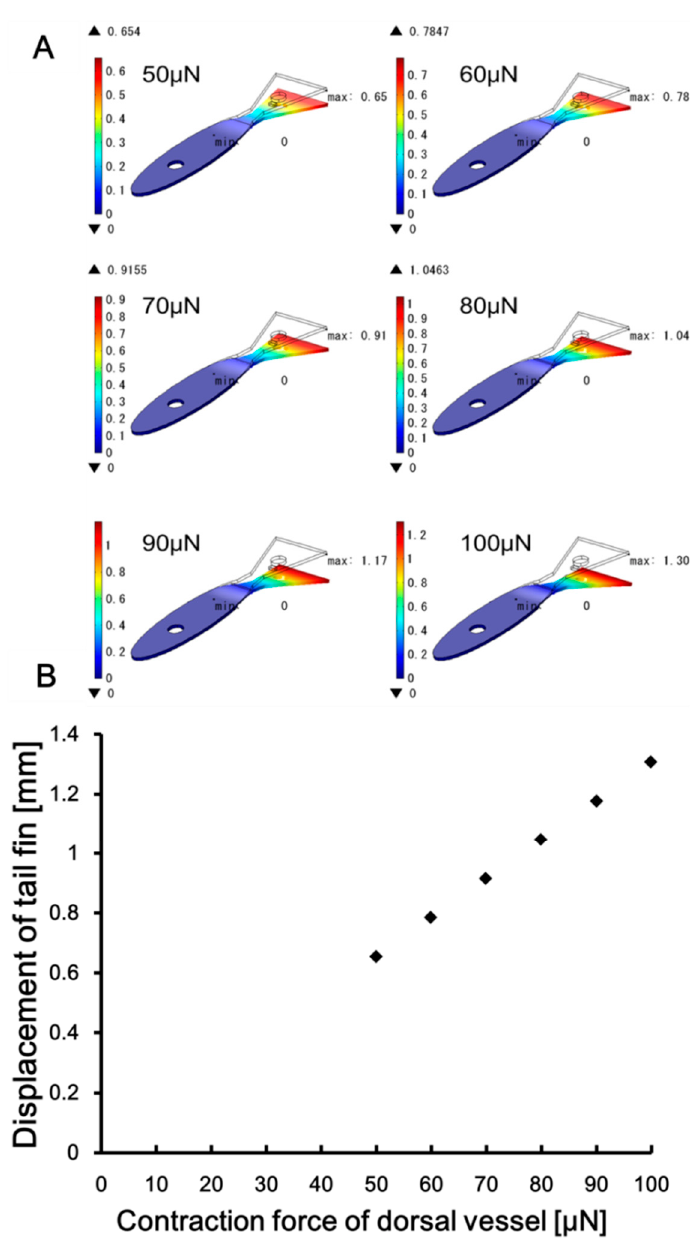
Figure 4. Simulation results obtained for the designed swimming robot body. ( A ) Deformation results are shown for the DV contraction forces of 50, 60, 70, 80, 90, and 100 µ N. ( B ) Simulation results show the displacement of tail fin increased with the contraction force.